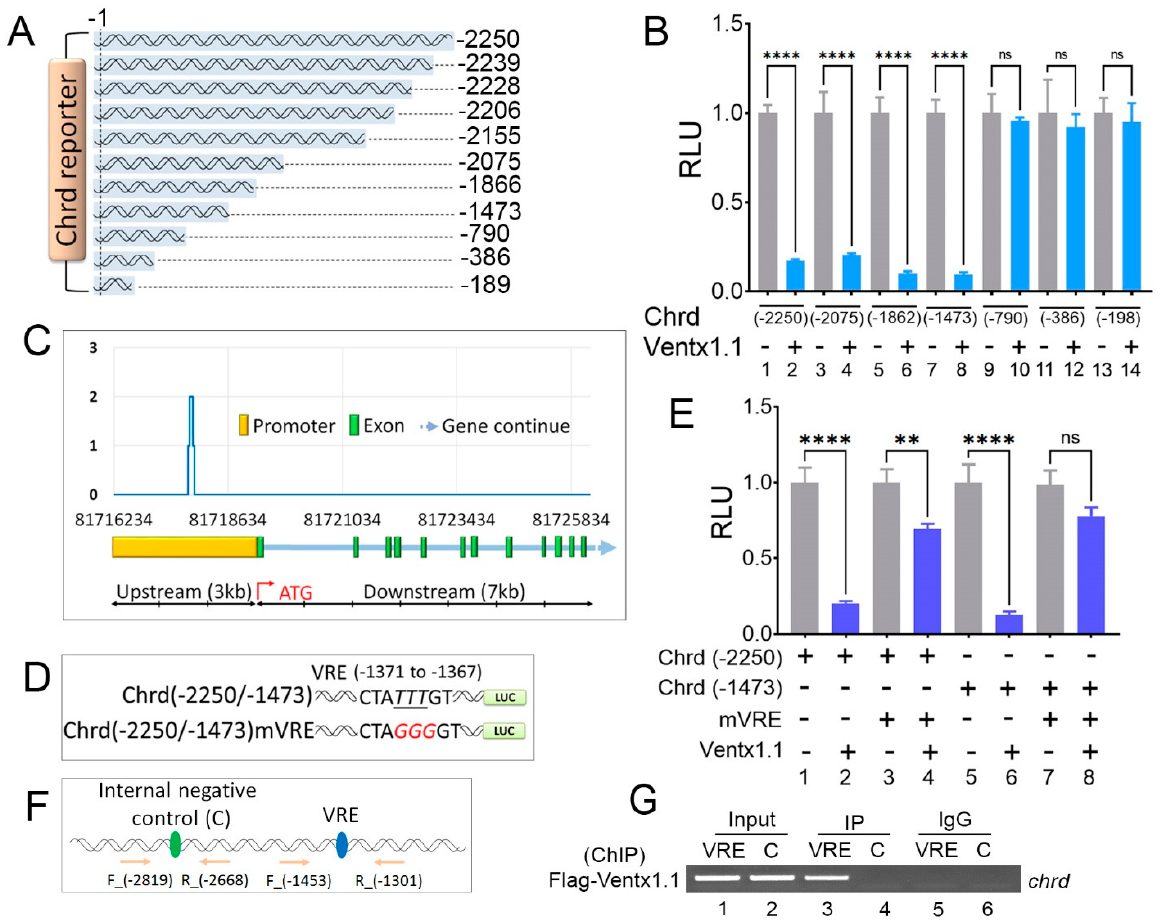
Figure 3. chrd promoter contains VRE. ( A ) Schematic representation of serially deleted chrd pro- moter constructs. ( B ) Relative luciferase activity of serially deleted chrd promoter constructs with or without Ventx1.1. ( C ) ChIP-sequencing coverage plot of Ventx1.1 within the chrd promoter region. ( D ) Schematic representations of site-directed mutagenesis and targeted nucleotides are italicized, underlined, and shown in red. ( E ) Relative luciferase activities of chrd(-2250), chrd(-2250)mVRE, chrd(-1473), and chrd(-1473)mVRE, with or without Ventx1.1. ( F ) The location of designed primers for VRE and the internal negative control ( C ). ( G ) Chromatin immunoprecipitation (ChIP) assay was performed to test the occupancy of Ventx1.1-Flag to VRE within the promoter region of chrd . ** p ≤ 0.01, **** p ≤ 0.0001, and n.s. denotes nonsignificant values.